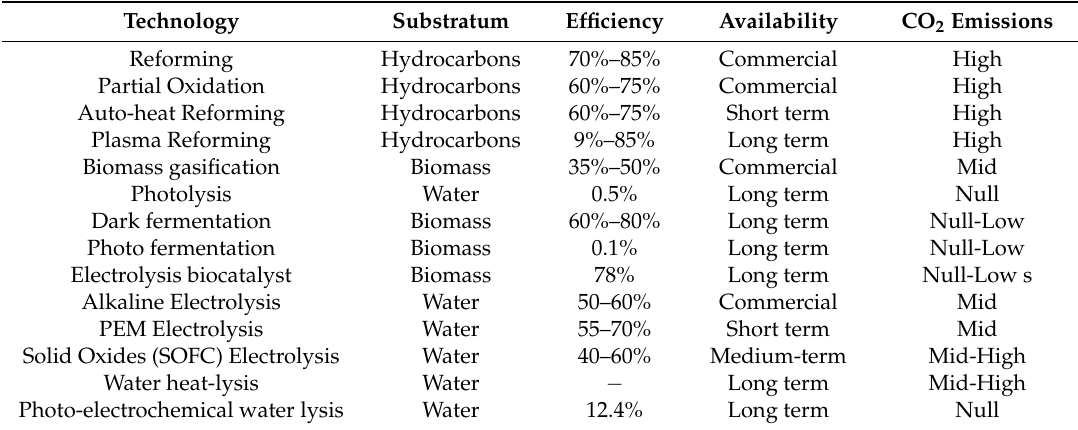
Table 1. Comparison between different technologies of hydrogen production [6].